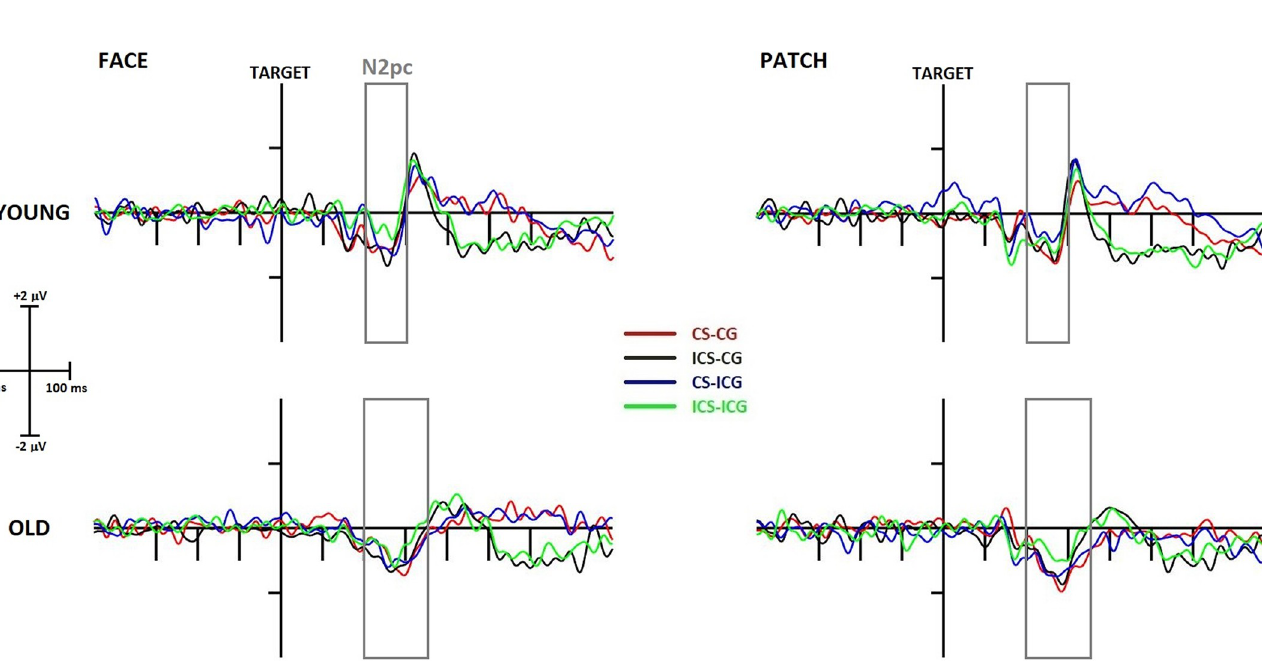
PLOS ONE | https://doi.org/10.1371/journal.pone.0233496 May 20,